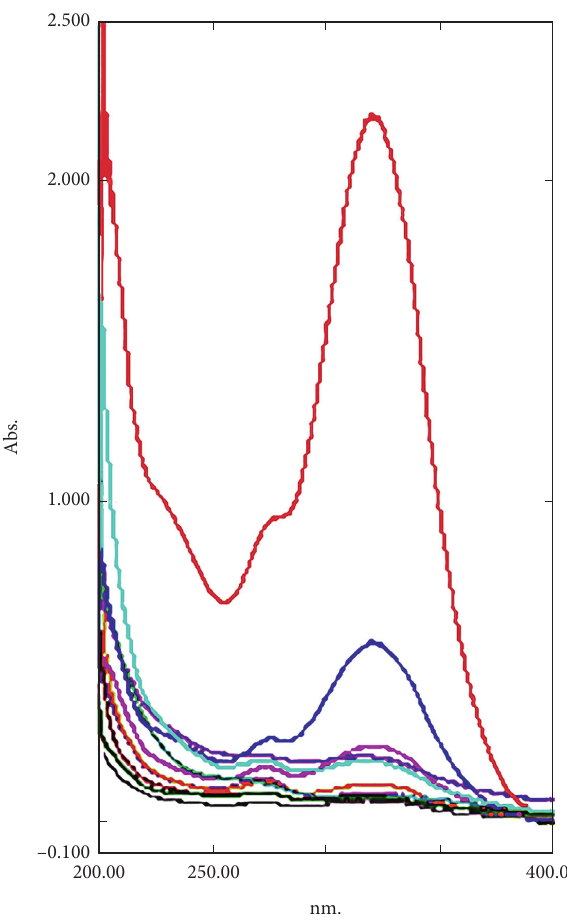
Figure 1: UV spectrophotometry report of the wavelengths specific for each antibiotic, 271nm for ciprofloxacin, 319nm for metro- nidazole, and 200nm for penicillin